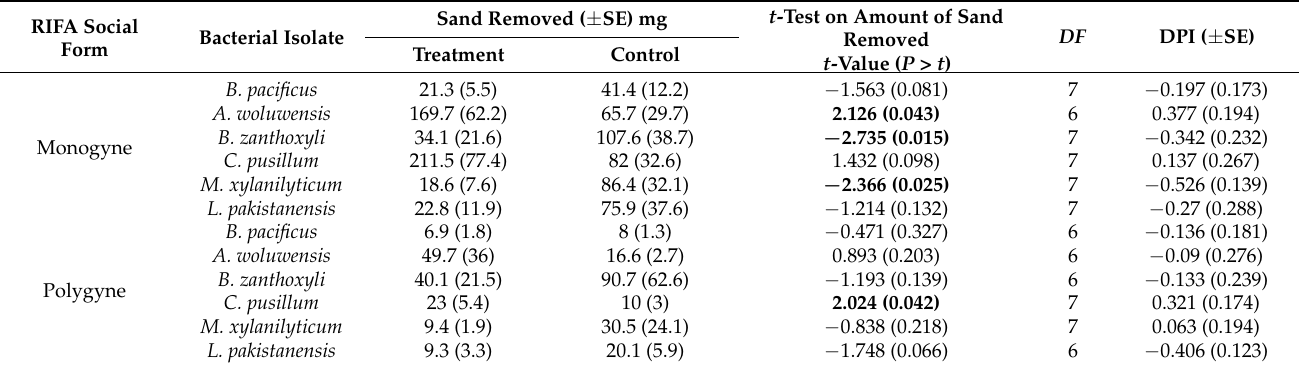
Table 7. Effects of soil-derived bacterial isolates (5 × 10 8 cells/mL) on S. invicta digging activity with 6 worker ants per assay after 18